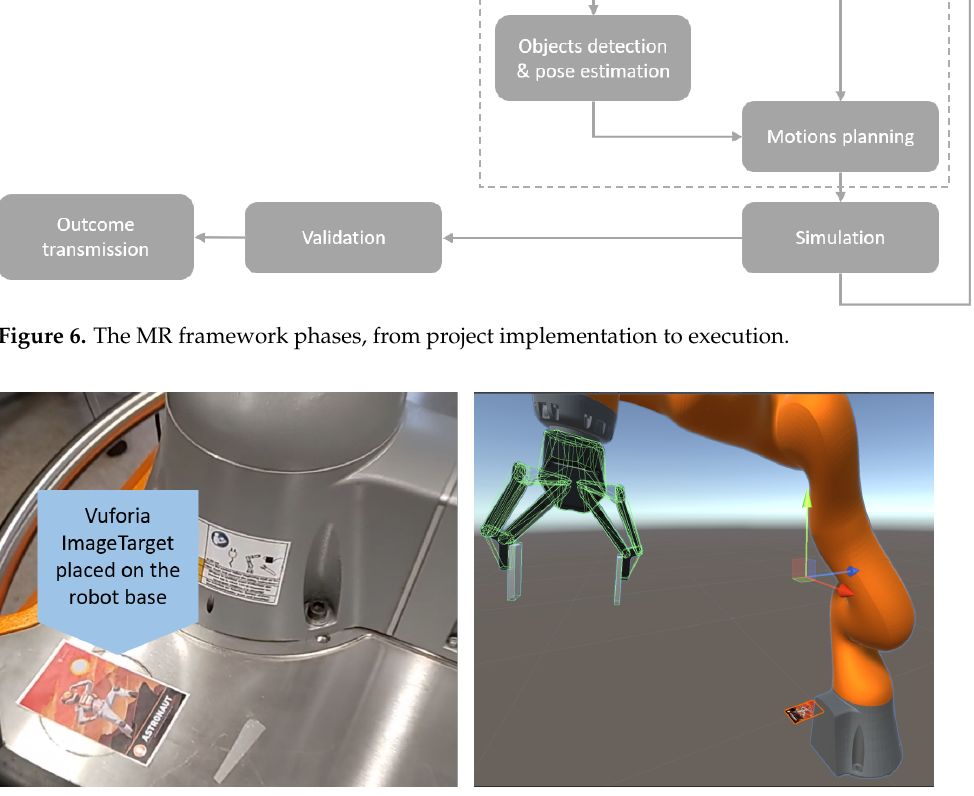
Figure 7. The Vuforia image target for project initiation and model